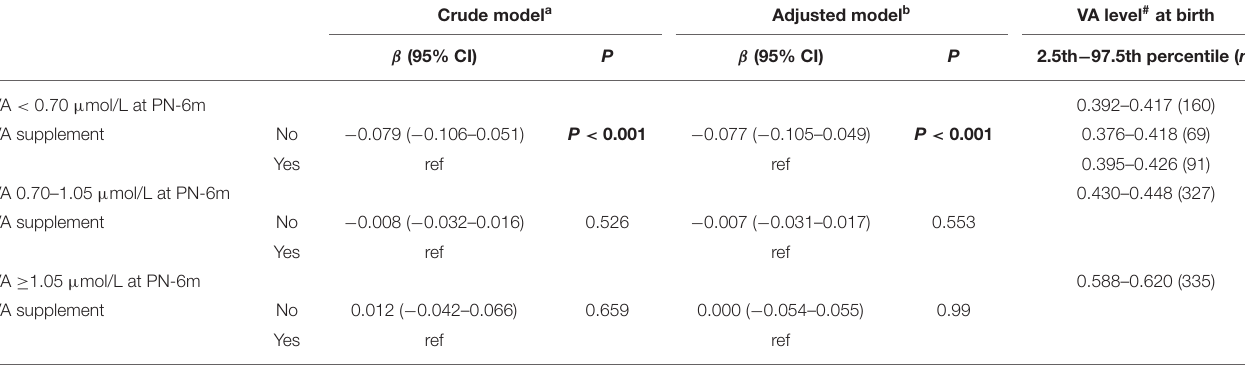
TABLE 2 | The VA levels at birth in different groups according to VA levels at PN-6m. Crude model a Adjusted model b VA level # at birth β (95% CI) P β (95% CI)